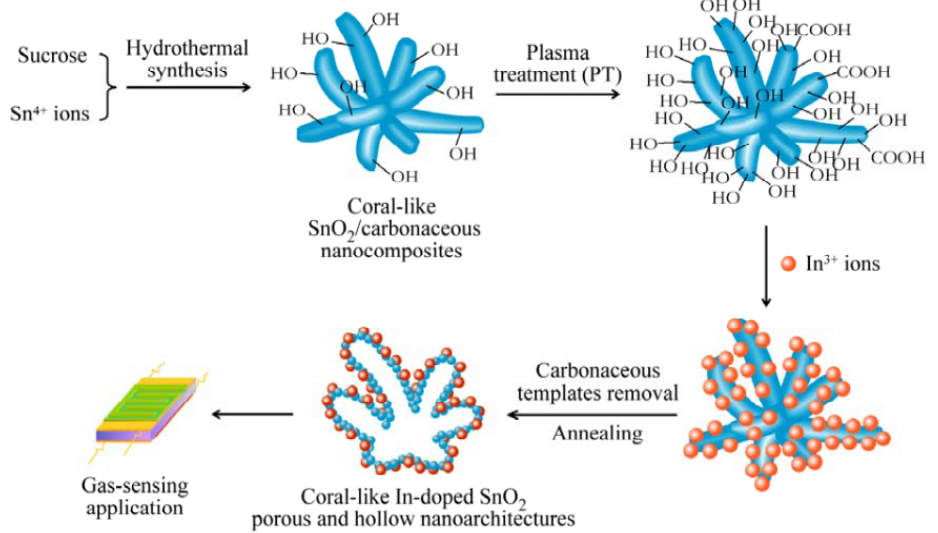
Figure 14. Schematic illustration of the plasma-assisted strategy for preparing highly dense coral-like nanostructures for gas-sensing applications. Reprinted with In-doped SnO 2 permission from [120]. Copyright (2011) IOP Publishing